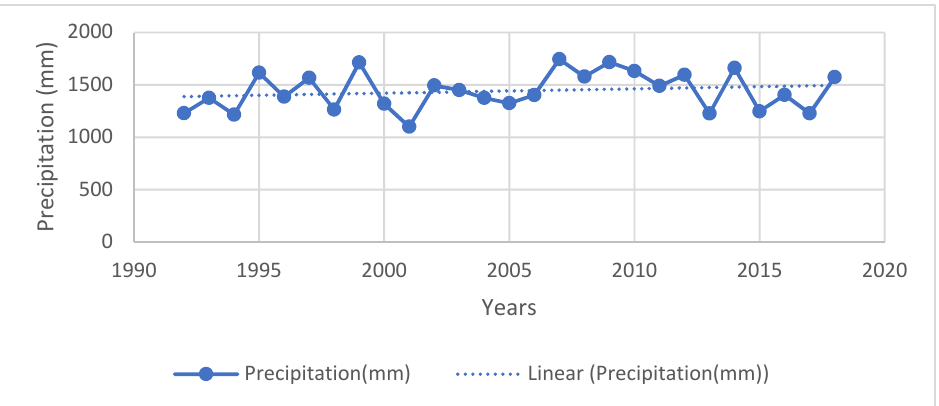
Figure 4. Linear regression model for yearly total precipitation over study area (dotted line is the fitted